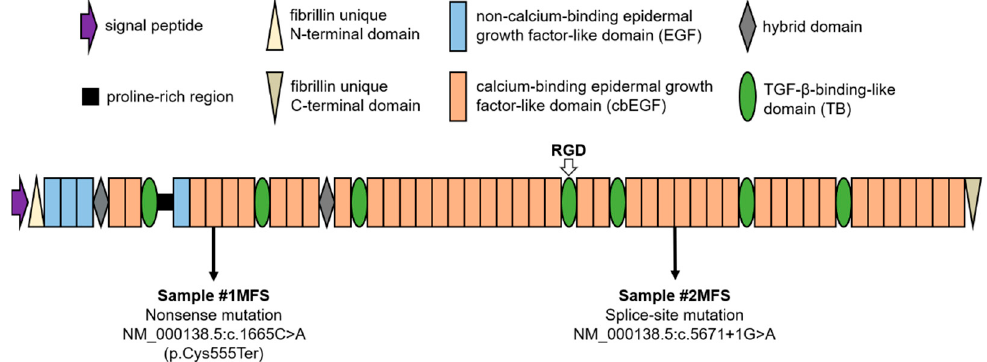
Figure 1. Schematic domain structure of fibrillin-1. The two fibrillin-1 gene (FBN1) mutations concerned in the current work are indicated with arrows (#1MFS, Marfan patient 1; #2MFS, Marfan patient 2). RGD, arginine-glycine-aspartic acid cell binding site. Fibrillin-1 molecules represent the main constituents of adult fi brillin micro fi brils